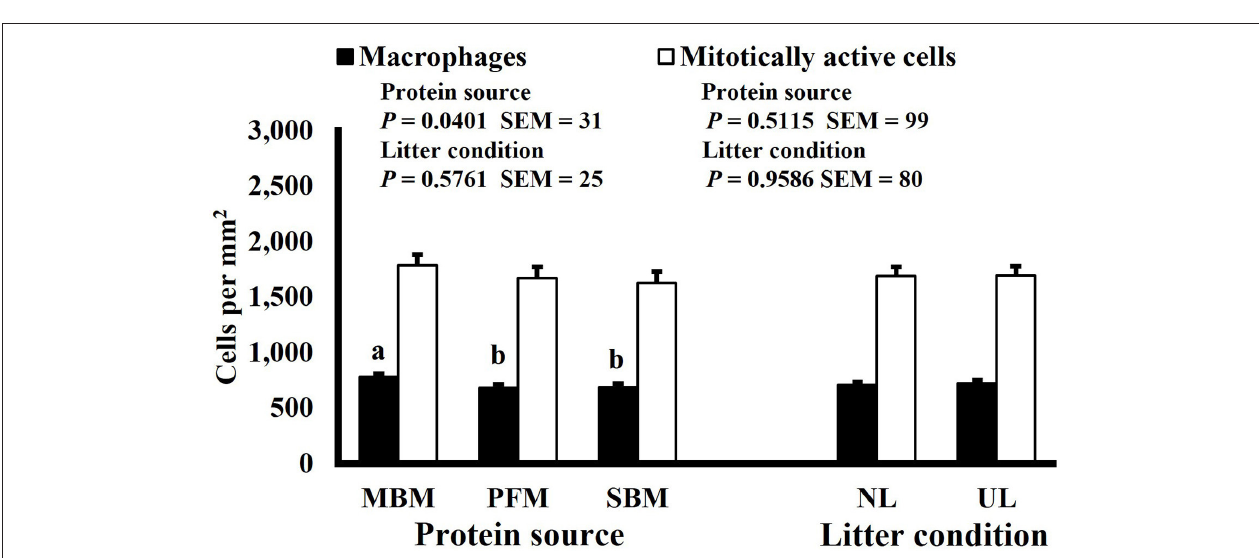
FIGURE 11 | Effect of bird age on macrophage (KUL01 + ) and mitotically active (BrdU + ) cell densities (cells per mm 2 ) in the duodenum of broilers ( n = 36 per d-of-age). a − d and A − D Bars of the same color with different superscripts differ at P ≤